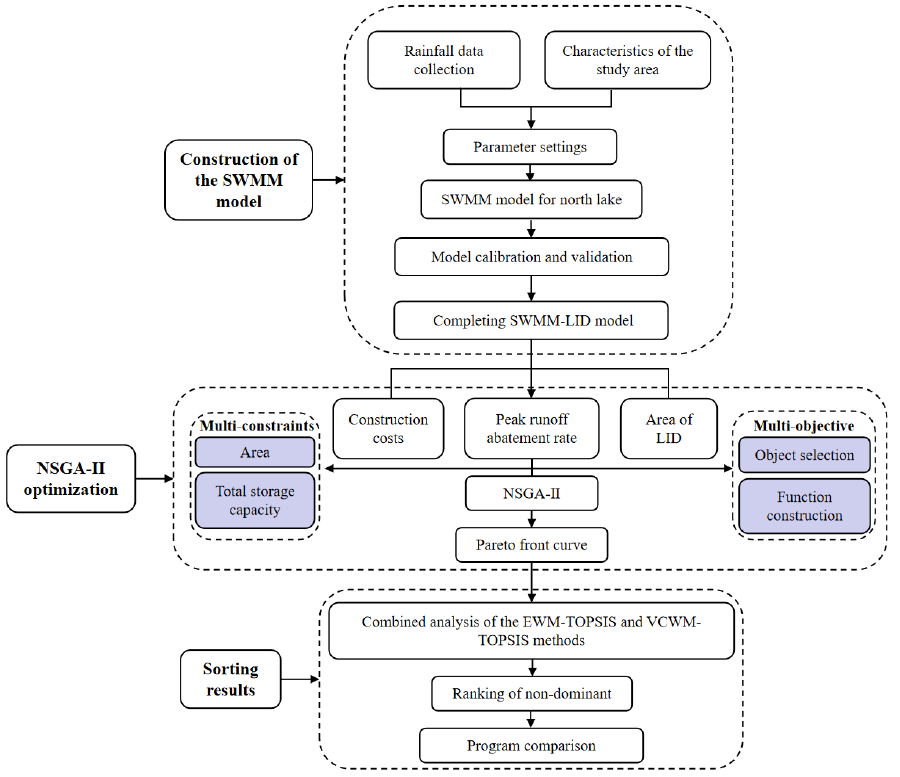
Figure 1. Flow chart of the research program.